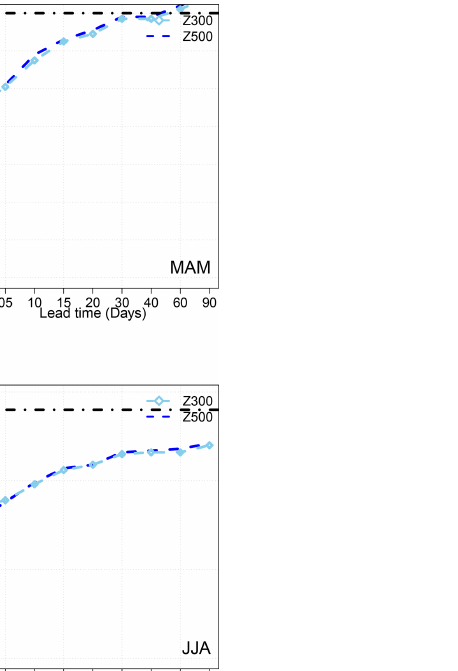
https://doi.org/10.5194/esd-14-273-2023 Earth Syst. Dynam., 14, 273–290,